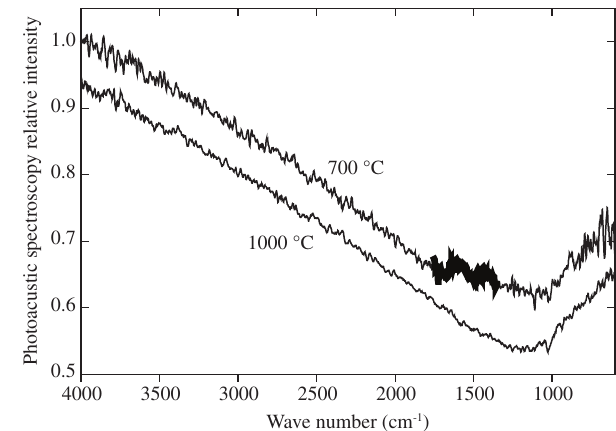
Figure 2. Resistivity behavior of RVC as function of the maximum temperature used in its manufacture.